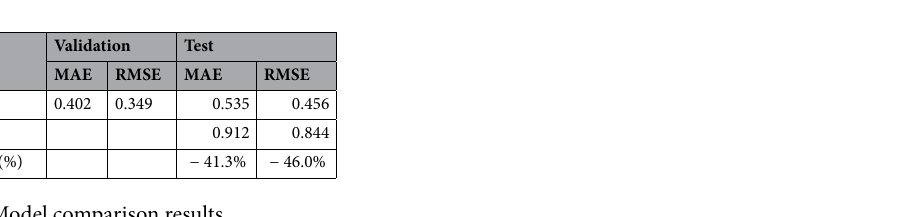
Table 5. Model comparison